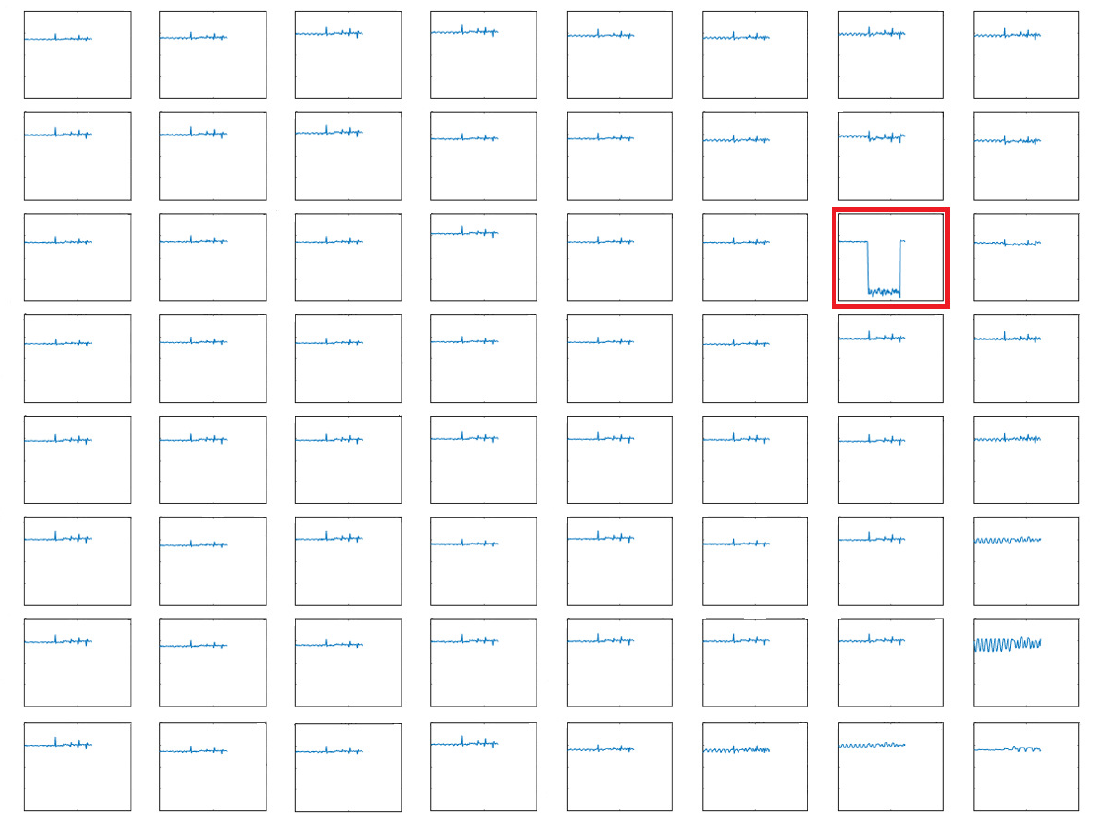
Figure 14. Graph of MaPMT measurements for 128 frames from 1st cell (left bottom corner) to 64th cell (right top corner). x -axis is the number of frame and y -axis is ADC value. On the 54th cell (red box), the ADC value abruptly dropped as soon as receiving the flash light.